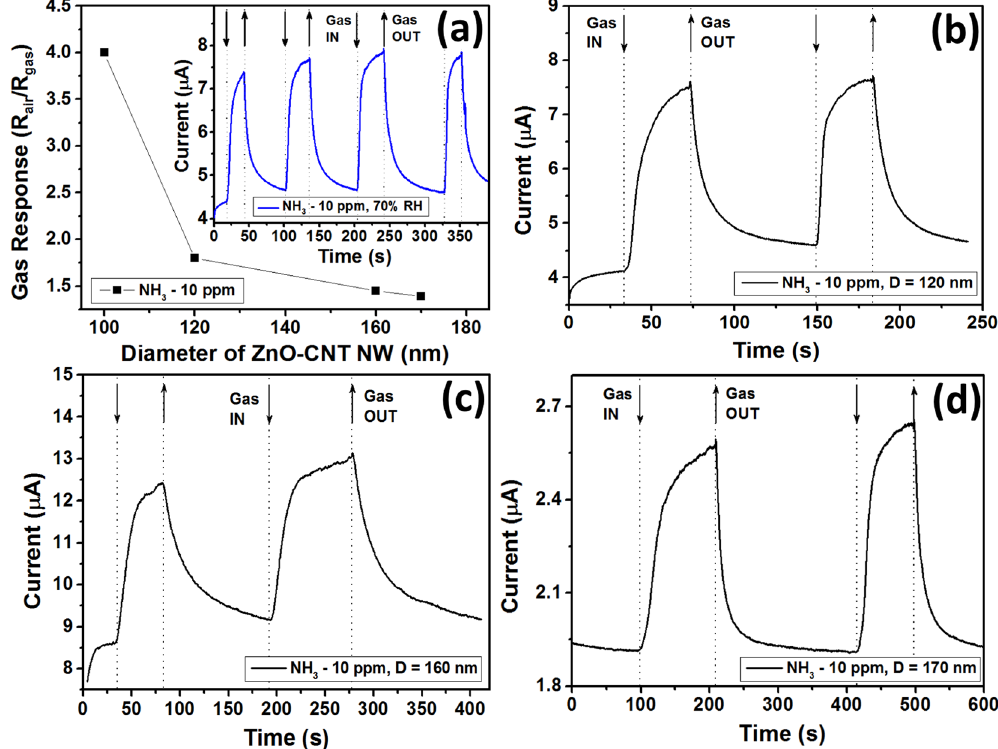
Figure 6. ( a ) Gas response at room temperature to 10 ppm of NH 3 of nanosensors based on individual ZnO- CNT NWs (from samples with 2.0 wt% CNT) versus diameter of NW. In the inset the room temperature dynamic NH 3 response (10 ppm) of nanosensor based on NW with D = 100 nm under 70% RH is presented. Dynamic gas response to 10 ppm of NH 3 at room temperature of nanosensor based on NW with: ( b ) D = 120 nm; ( c ) 160 nm; and ( d ) 170